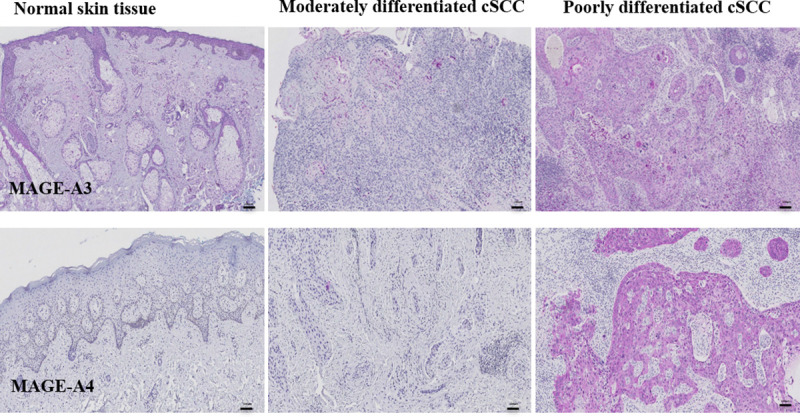
Immunohistochemistry of MAGE-A3 and MAGE-A4 expression in normal skin tissue and moderately and poorly differentiated cSCC tumors.Images in the upper row represent MAGE-A3 expression as assessed by immunohistochemistry, whereas images in the bottom row depict MAGE-A4 expression. Upregulated expression of MAGE-A3 and MAGE-A4 is noted in poorly differentiated cSCC with PNI. Scale bar in each image indicates 100 μm.